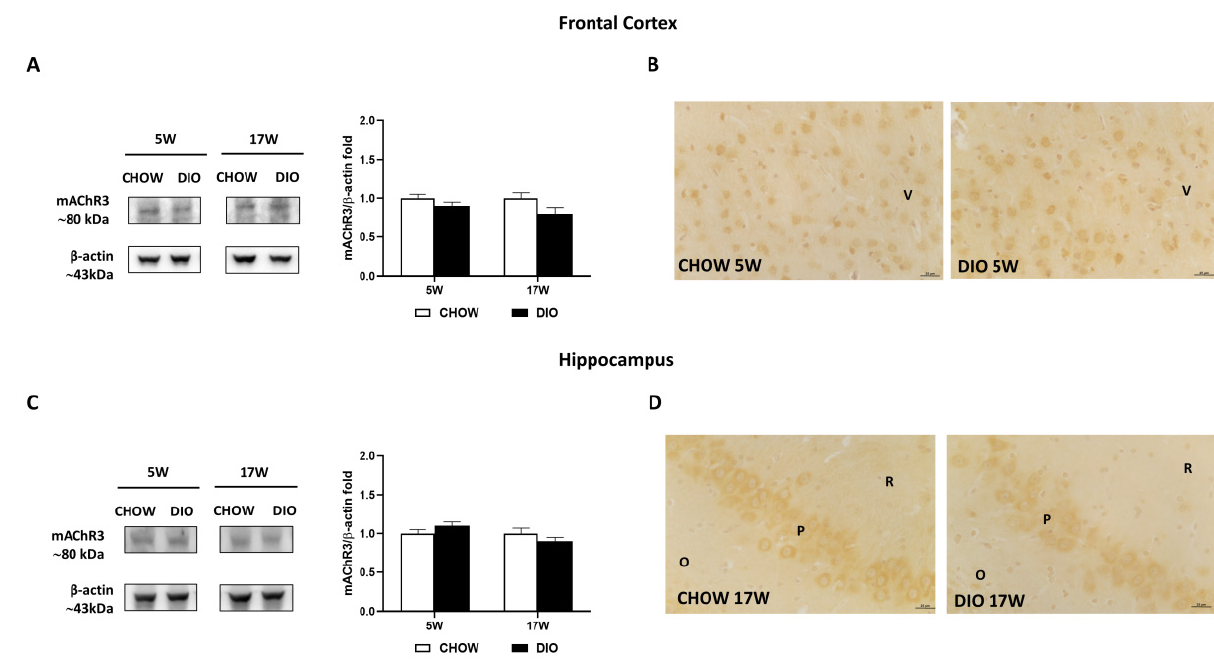
Figure 6. Western blot and immunohistochemistry of muscarinic acetylcholine receptor subtype 3 (mAChR3). Samples of frontal cortex ( A ) and hippocampus ( C ) from rats fed with standard diet (CHOW rats) and high-fat diet (DIO rats) for 5 and 17 weeks were immunoblotted using specific anti- mAChR3. Graphs report the densitometric data with CHOW rats as control, and β -actin was used as a reference loading protein. Data are mean ± S.E.M. CHOW rats 5 weeks n = 8; DIO rats 5 weeks n = 8; CHOW rats 17 weeks n = 8; DIO rats 17 weeks n = 9. Representative pictures of CHOW and DIO rats in frontal cortex after 5 weeks ( B ) and hippocampus, CA3 subfield, after 17 weeks ( D ) of diet. V, fifth layer of frontal cortex; O, stratum oriens ; P, pyramidal neurons; R, stratum radiatum . Scale bar: 25 μ m.